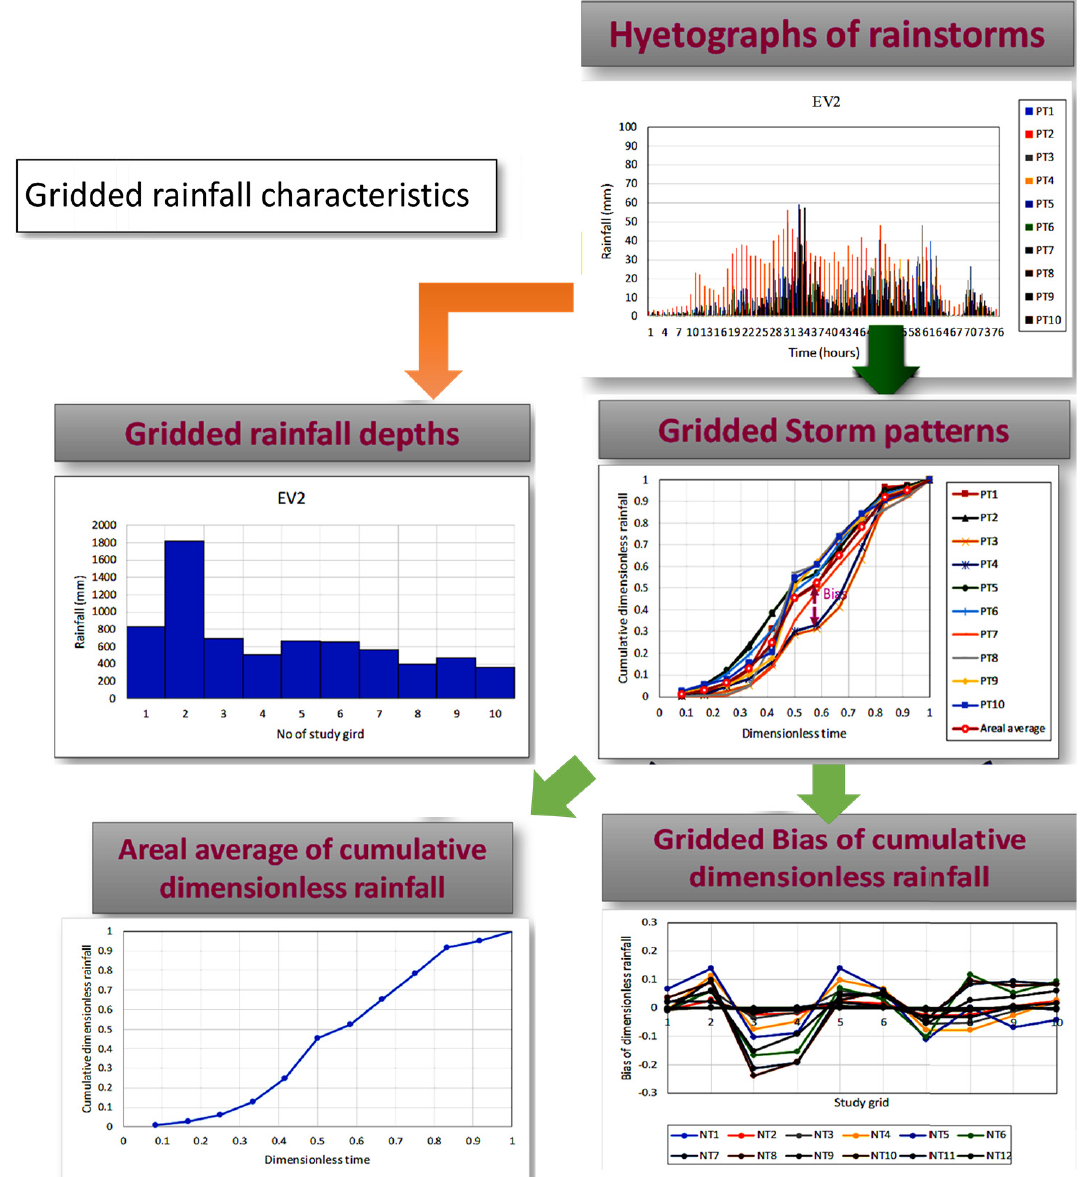
Figure 2. Graphical process of extracting the gridded rainfall characteristics from observed photographs of rainstorm events [22].